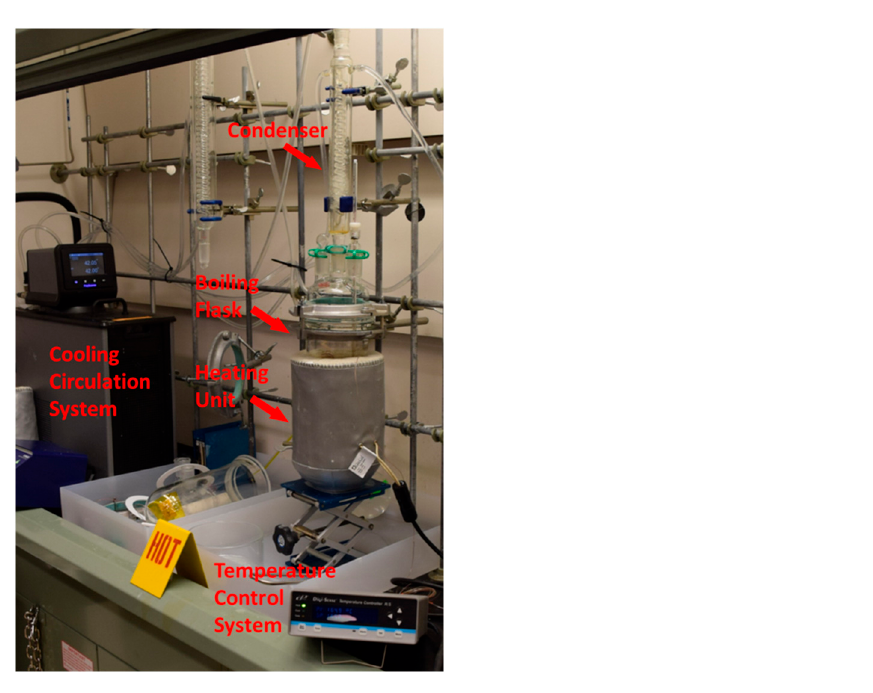
Figure 2. Four-point bend apparatus [50]. Reprinted/adapted with permission from Reference [50].